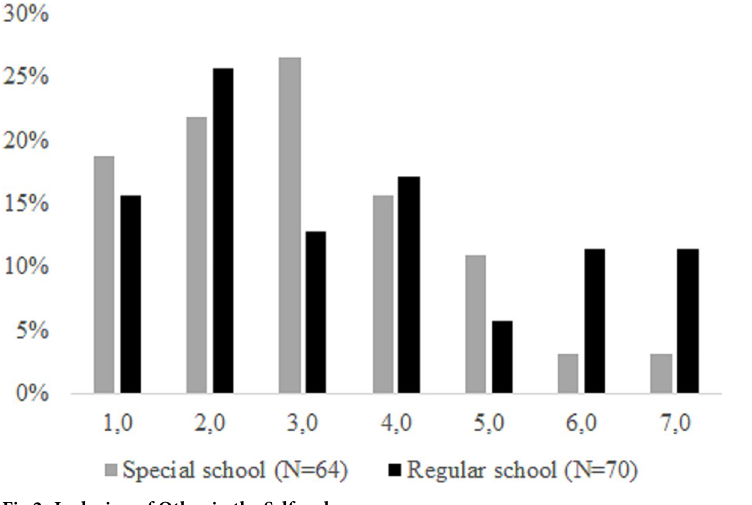
Fig 2. Inclusion of Other in the Self